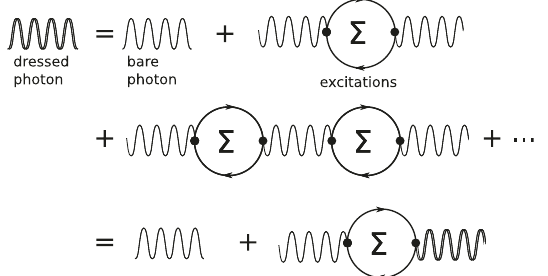
Fig. 4 Diagrammatic Dyson equation. The bare cavity photon propagator (thin wavy curve) is dressed via multiple absorption and re-emission processes by TMDC excitations ( Σ ). The dressed cavity photon Green ’ s function is depicted by a thick wavy curve. The solution of this diagrammatic equation is written in Eq (4) in the algebraic